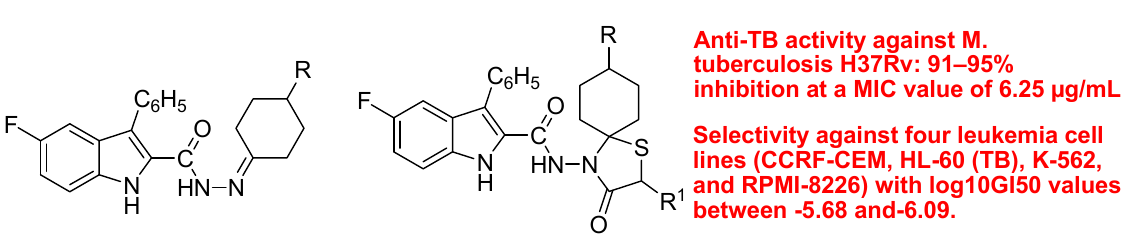
Figure 37. Synthesis of functionalized